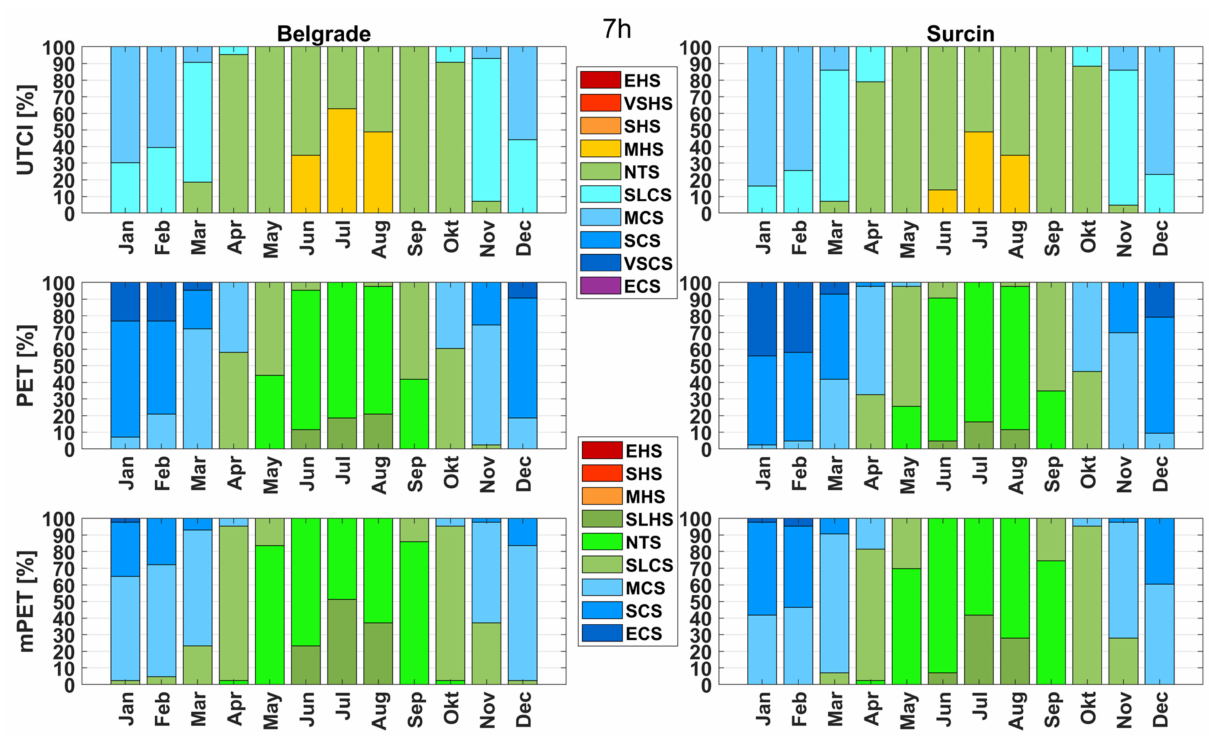
Figure 2. Monthly frequencies (expressed in percentages) of the represented thermal heat stress classes of all three PET, mPET and UTCI indices in Belgrade and Surcin areas at 7 h and 14 h